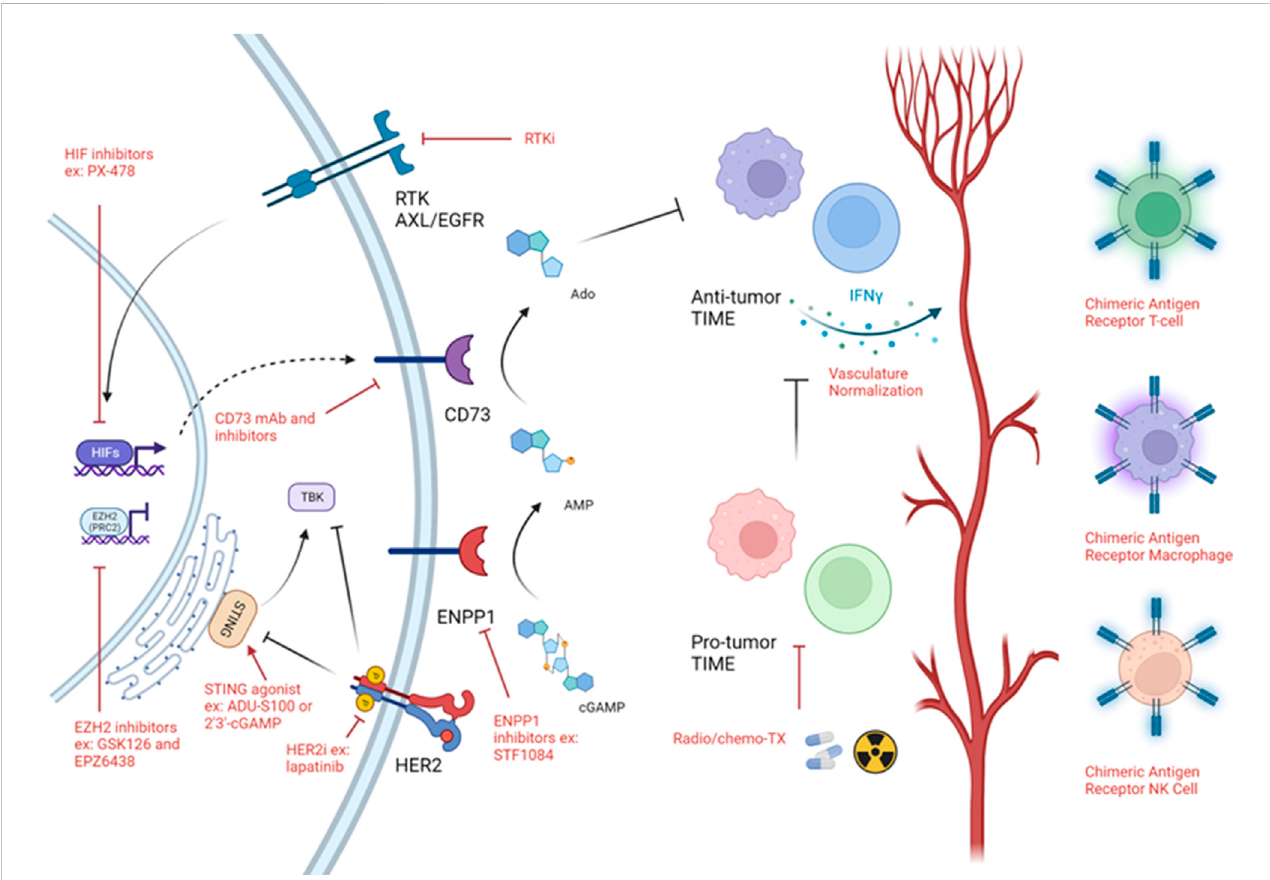
FIGURE 3 Strategies targeting immune cold TIME. Schematic of strategies used to target immune cold timors. Black arrows demonstrates a biologically activating pathway. Black fl at head demonstrates a biologically inhibitory pathway. Red arrow implies activating intervention. Red fl at head implies inhibitory intervention. Figure generated with